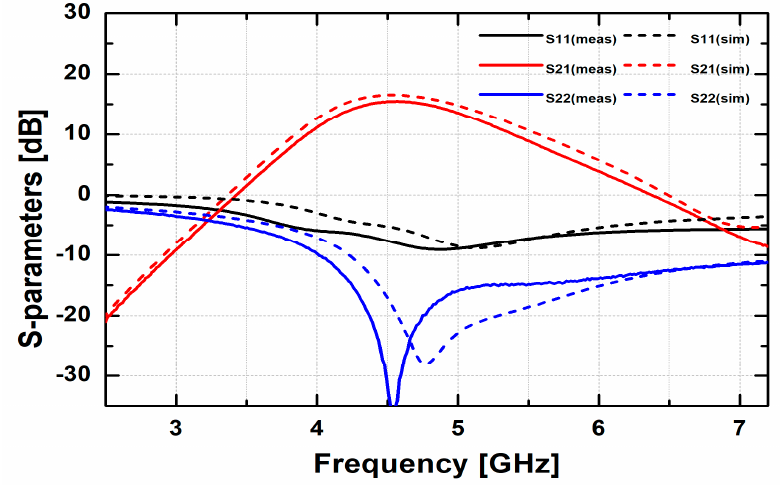
Figure 6. The simulated and measured S-parameters of the proposed PA.